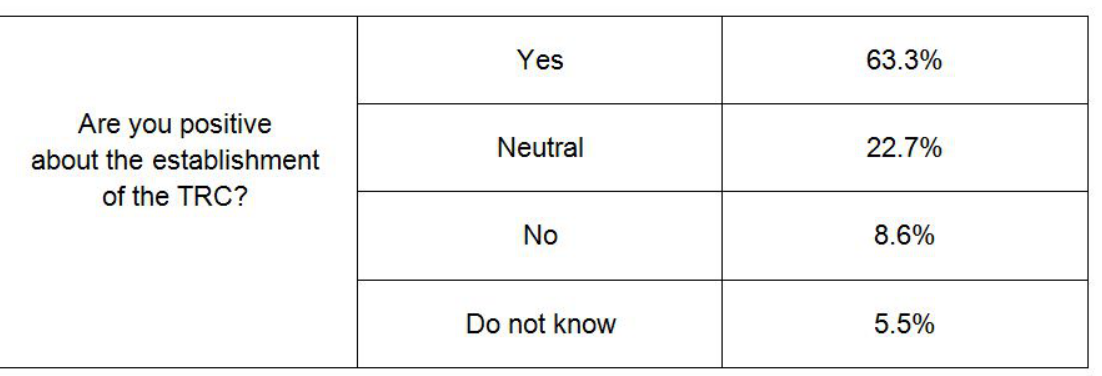
Table 2: Results of the students’ answers on how positive they are about the establishment of the